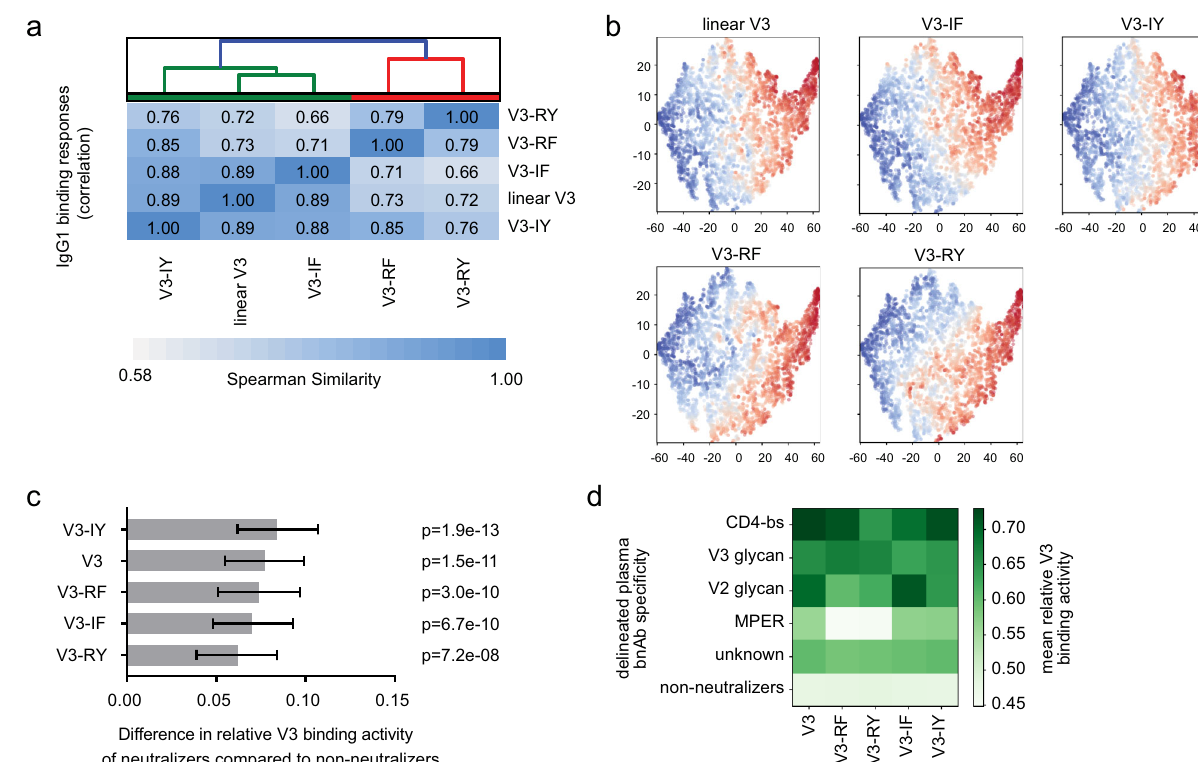
Difference in relative V3 binding activity of neutralizers compared to non-neutralizers Fig. 6 The V3-crown IgG1 response in HIV-1 infection recognizes distinct V3-crown conformations and is linked with the development of neutralization breadth. Relative plasma IgG1 binding activity (distributed uniformly in [0,1]) to linear V3 and structurally constrained BG505 V3-crown mimetics (V3-IY, V3-IF, V3-RF, V3-RY) from 4281 chronic HIV-1 infected individuals enrolled in the Swiss 4.5 K Screen 13,47 were obtained and assessed in the context of neutralization activity data of the cohort (de fi ned as a cross, broad and elite neutralization, or no neutralization) available from 47 . Source data are provided as Supplementary Data 10. a Unweighted average linkage hierarchical clustering based on the Spearman correlation of relative V3-crown peptide IgG1 binding activities across the cohort indicates reactivity clusters dependent on V3-crown peptide conformation. b A two-dimensional representation (t-SNE map) of all 4,281 plasma samples based on relative IgG1 binding activities to the fi ve V3 peptides. Red color denotes high binding activity and blue color denotes low binding activity to the V3 peptide indicated on the top of each panel. c Comparison of relative V3 binding activity in plasma from patients with ( n = 909) and without ( n = 2250) heterologous virus-neutralizing activity by multivariable linear regression analysis. Grey bars indicate the mean difference in relative binding activity for individual peptides (two-tailed p-values from t-test are provided; they are not adjusted for multiple testing). Black error bars indicate the 95% con fi dence intervals. These data belong to a comprehensive analysis of host, virus, and disease parameters, shown in Supplementary Fig. 14c and Supplementary Data 11, where only the n = 3159 patients with complete information on all parameters were included. d The top 105 neutralizing plasmas of the cohort were strati fi ed by bnAb epitope speci fi city (using neutralization fi ngerprinting 47 ) and their mean relative V3 binding activities were